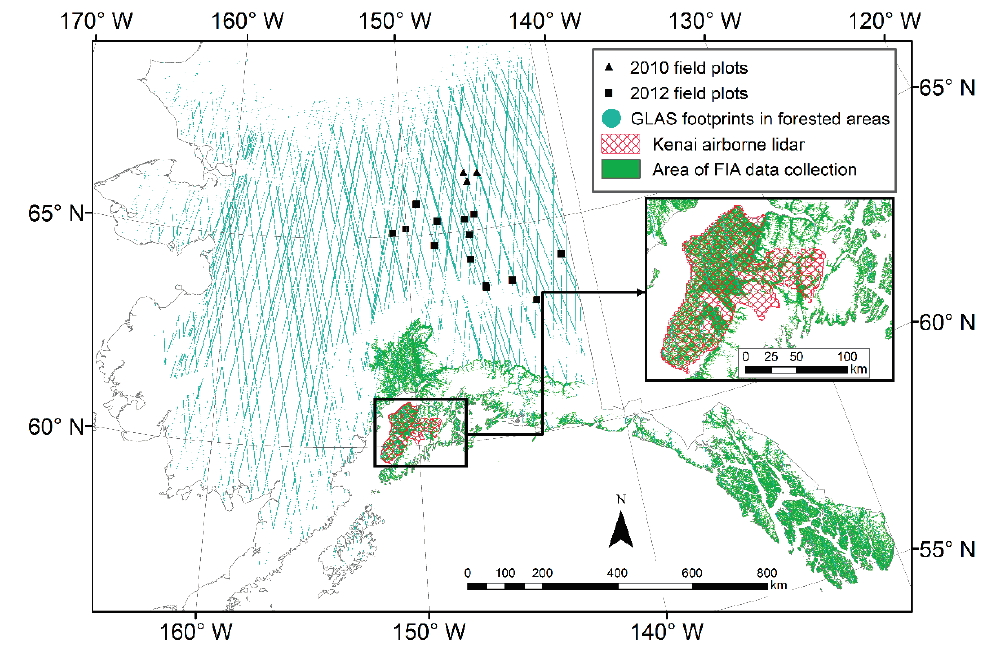
Figure 2. Map of Alaska showing the distribution of the GLAS spaceborne LiDAR, airborne LiDAR collected over the Kenai Peninsula, and various field observations used for the accuracy assessment of the final forest canopy height